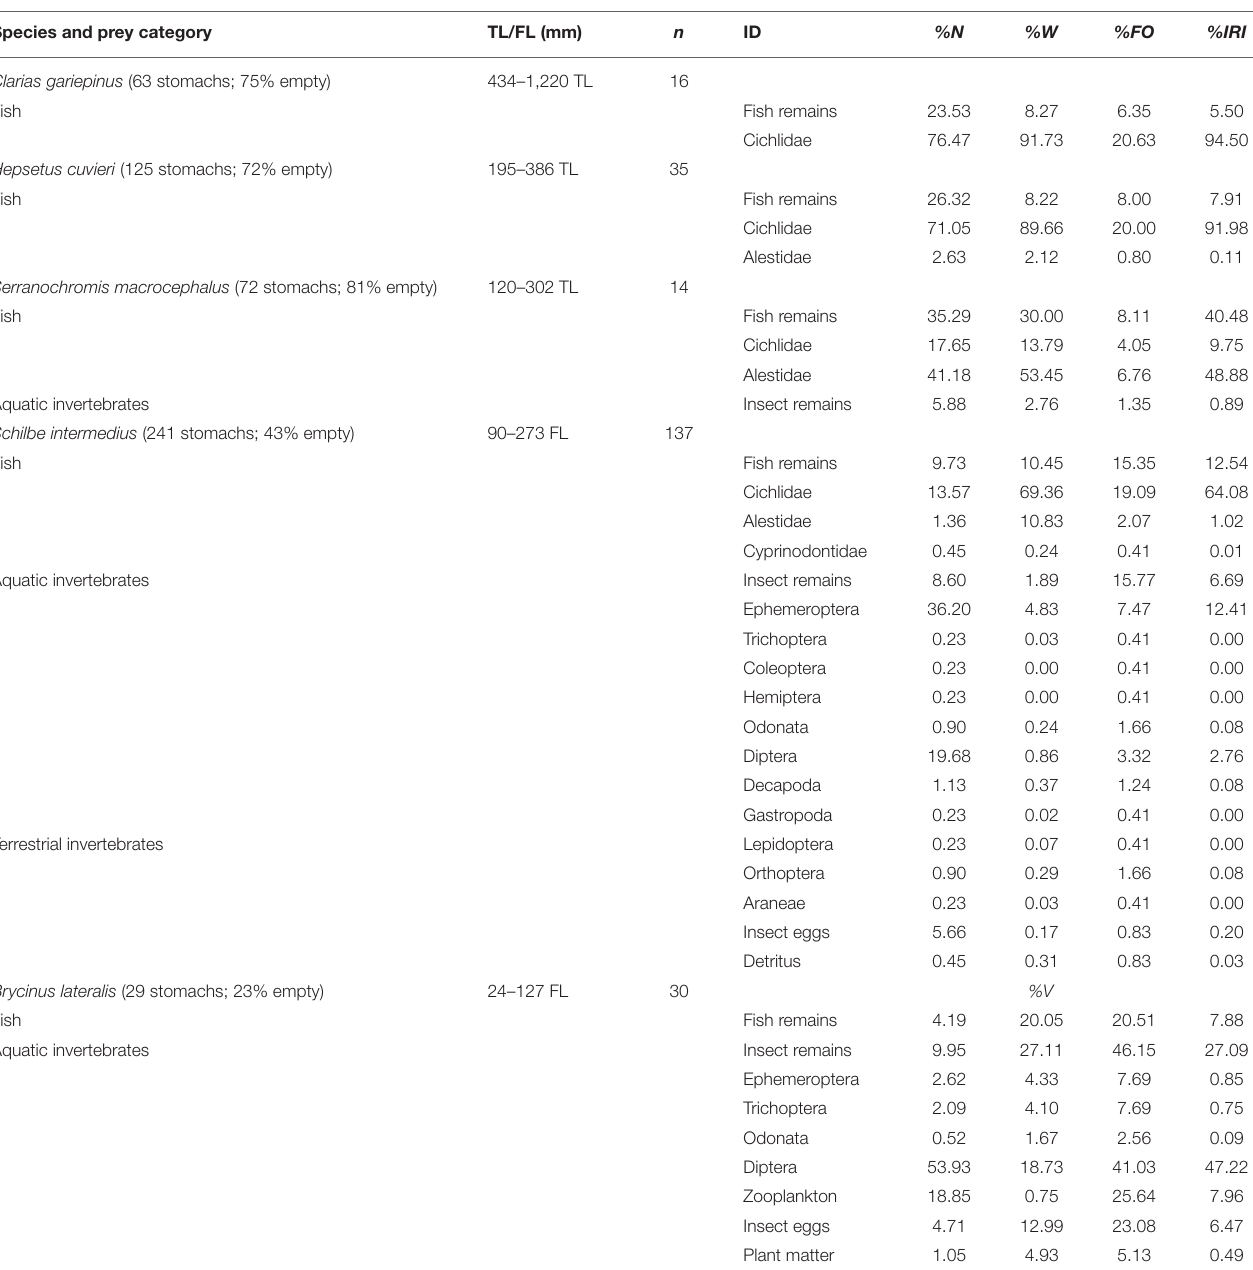
TABLE 2 | Stomach contents of fish species (no. of stomachs; % empty) and their length, by % number ( %N ), % weight ( %W ) and % frequency of occurrence ( %FO ), and the % index of relative importance ( %IRI ) of each prey category. Species and prey